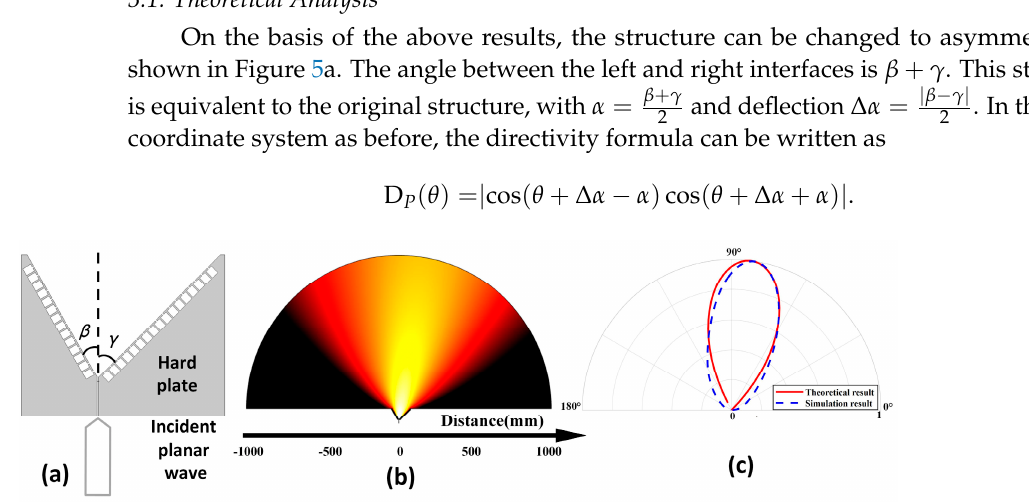
Figure 5. ( a ) Schematic of the structure. ( b ) Simulated sound pressure for | Z s / ρ 0 c 0 |≈ 0. ( c ) Theoreti- cal and simulated sound fields induced by the structure.